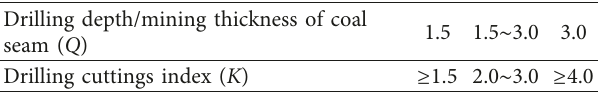
Table 1: Warning index of drilling cuttings for judging rock burst. Drilling depth/mining thickness of coal seam ( Q ) Drilling cuttings index ( K